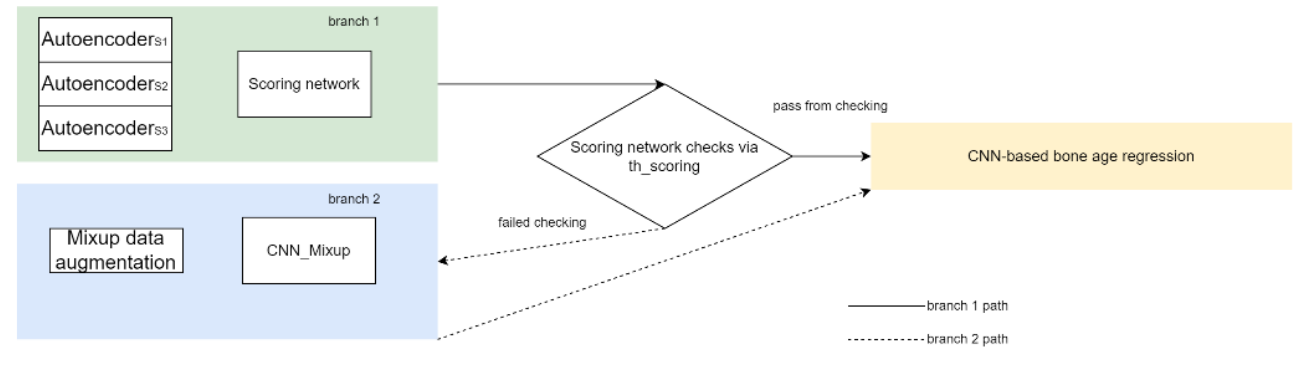
Figure 2. Framework of DAIIBAA.